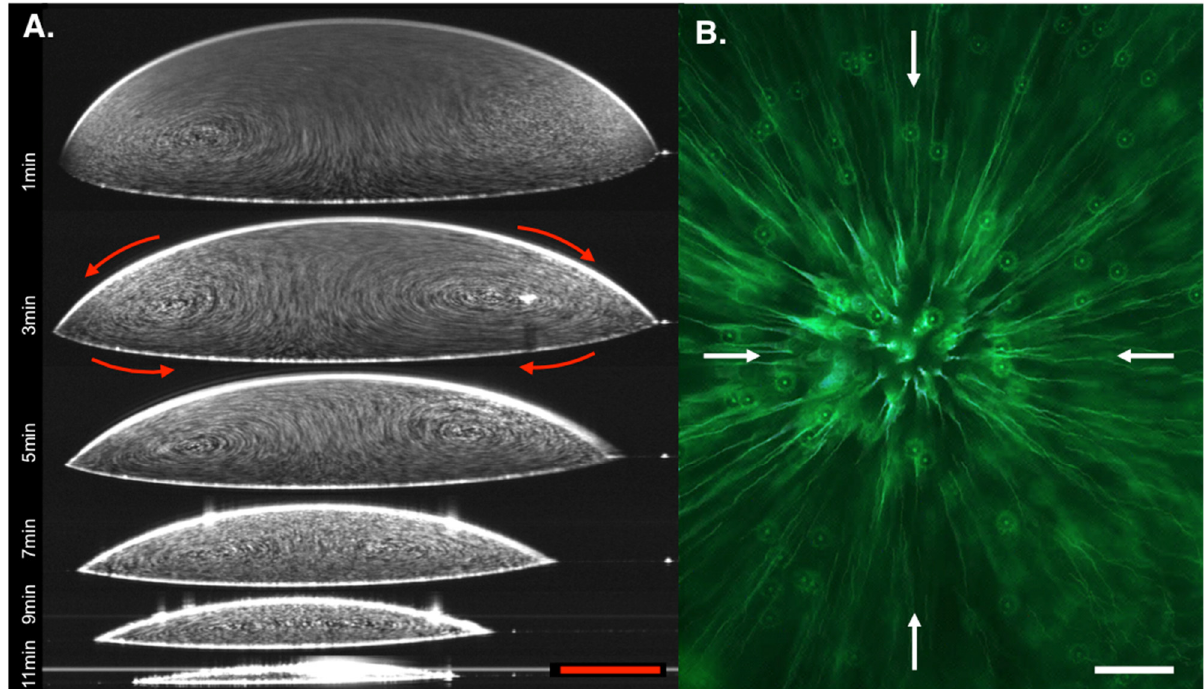
Figure 6. Time-lapse images demonstrate formation of Marangoni flow patterns oriented radially inward along the substrate. ( A ) Starting at 1 min, and every 2 min thereafter until the droplets dried, composite images containing 800 repeated frames in 36 s were taken at the diameter of the 1 µ L droplet to image the flow fields produced in the droplet using optical coherence tomography. Flow direction is indicated by red arrows. ( B ) Top-view microscopy image showing movement of particles inward along the substrate surface of a drop in a 5 µ L droplet. A single image was captured using fluorescent imaging with an exposure time of 4 s. White arrows indicate flow direction. Sample contains 10 6 and 10 4 particles/ µ L. Composite videos for OCT and microscopy series can be found in the Supplementary Information (Videos S1 and S2). Red scale bar = 125 µ m. White scale bar = 100 µ